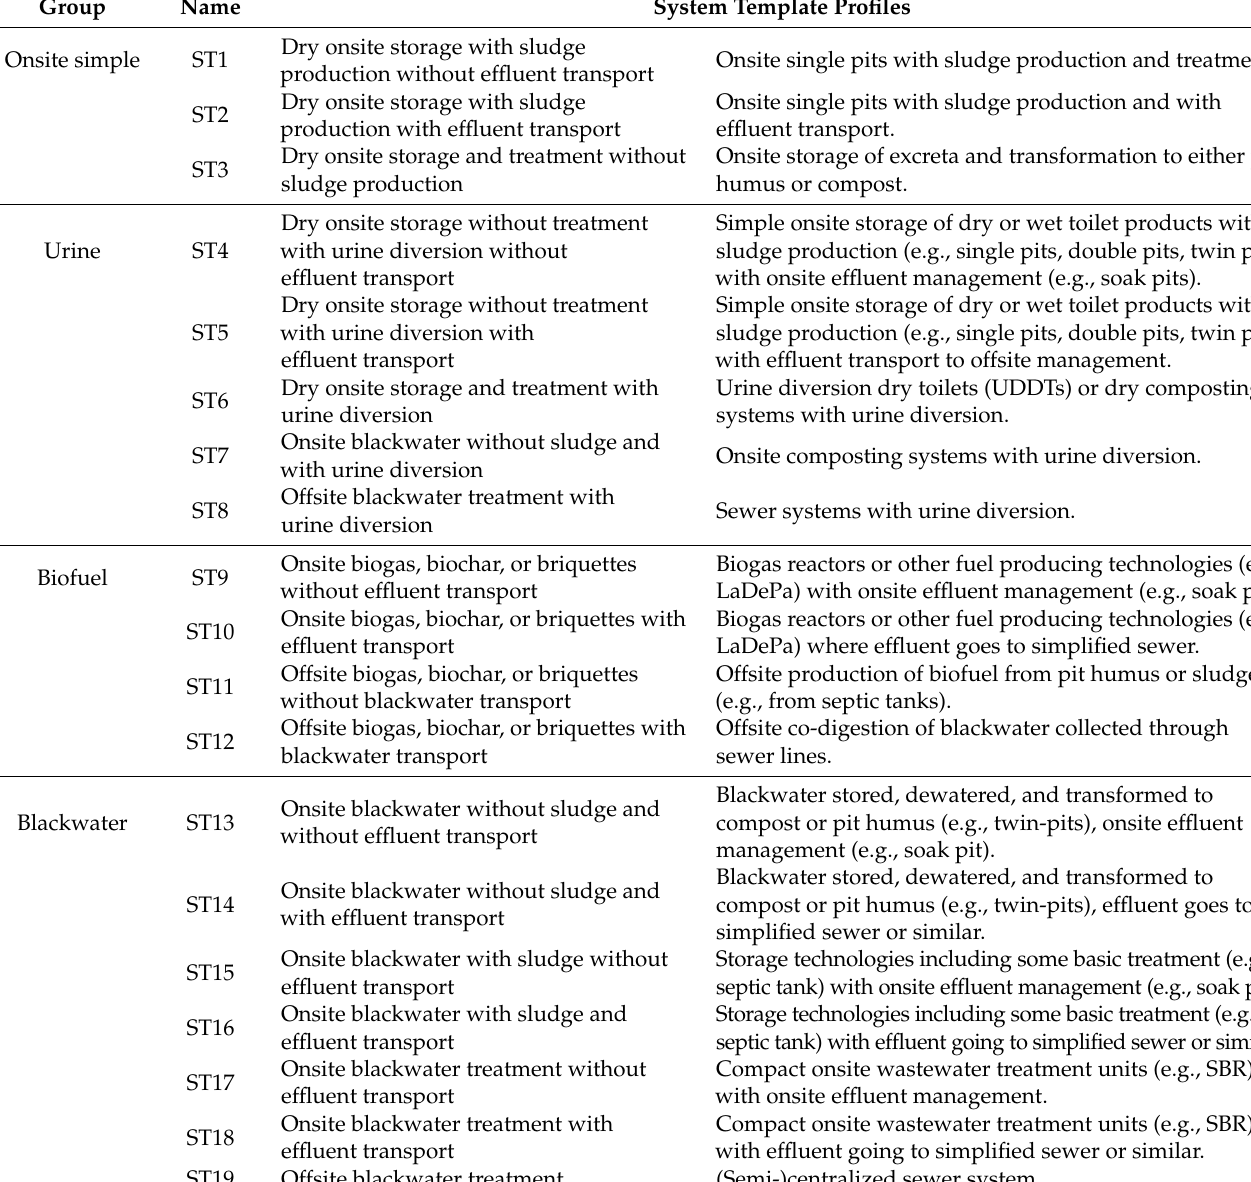
Table 1. System template based on